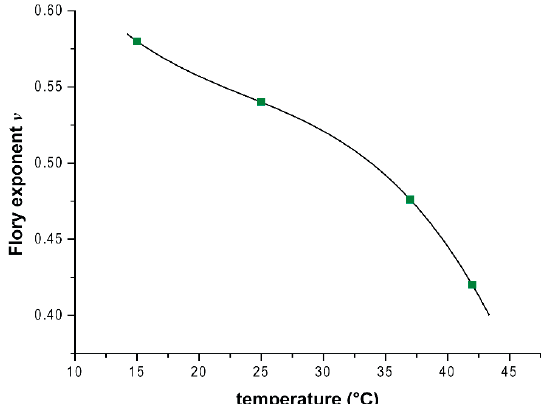
Figure 4. The measured ( green points ) and interpolated ( line ) evolution of the Flory exponent across the experimental temperature range.